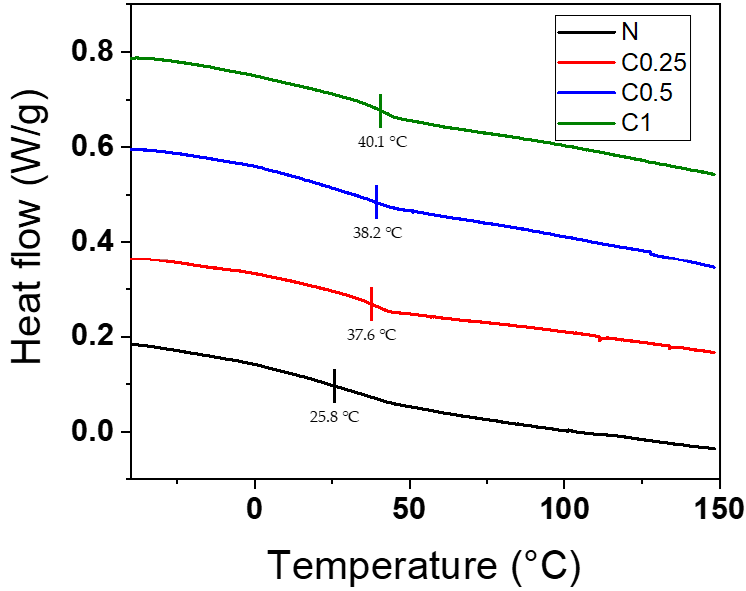
Figure 7. DSC curves of N, C0.25, C0.5, and C1.